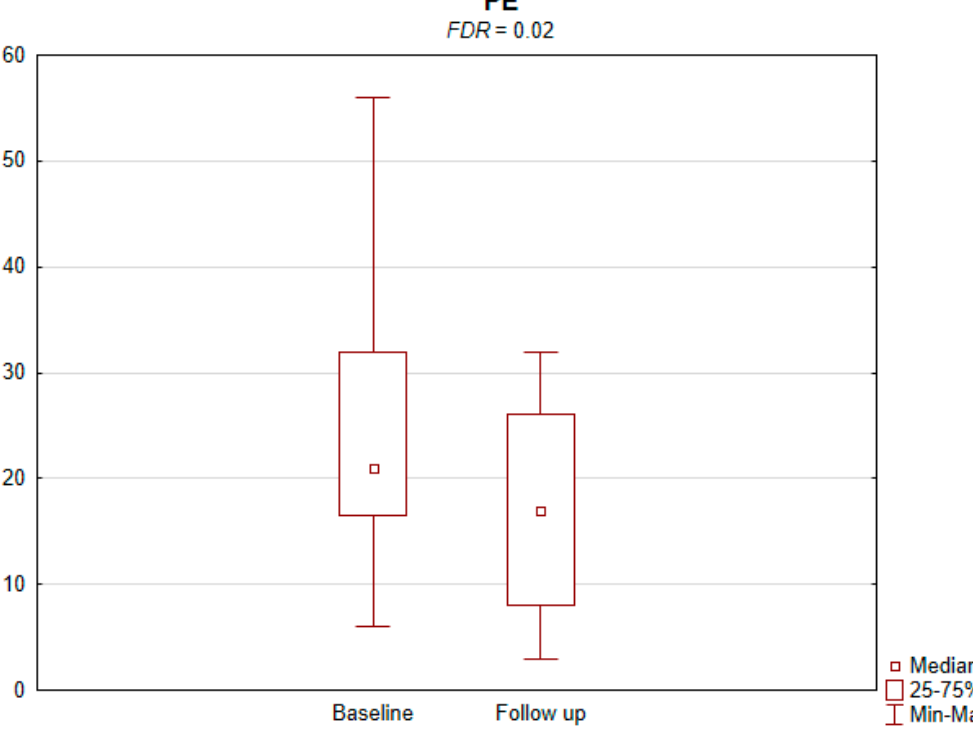
Figure 6. Perseverative errors (PE) in Wisconsin Card Sorting Test before and after the intervention. FDR —false discovery rate.